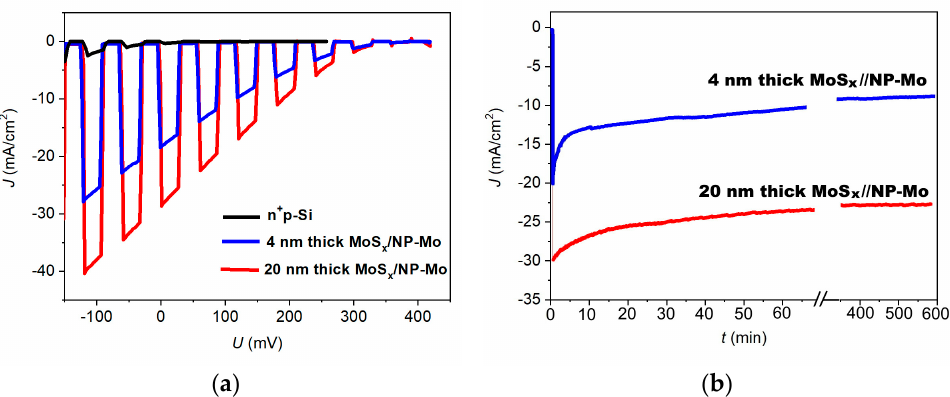
Figure 11. ( a ) LSV curves for n + p-Si without and with thin and thicker a-MoS x /NP-Mo catalytic films; ( b ) Chronoamperometric curves for n + p-Si covered with thin and thicker a-MoS x /NP-Mo catalytic films. The curves were measured under ( a ) chopped and ( b ) continuous illumination with an intensity of 100 mW/cm 2 .